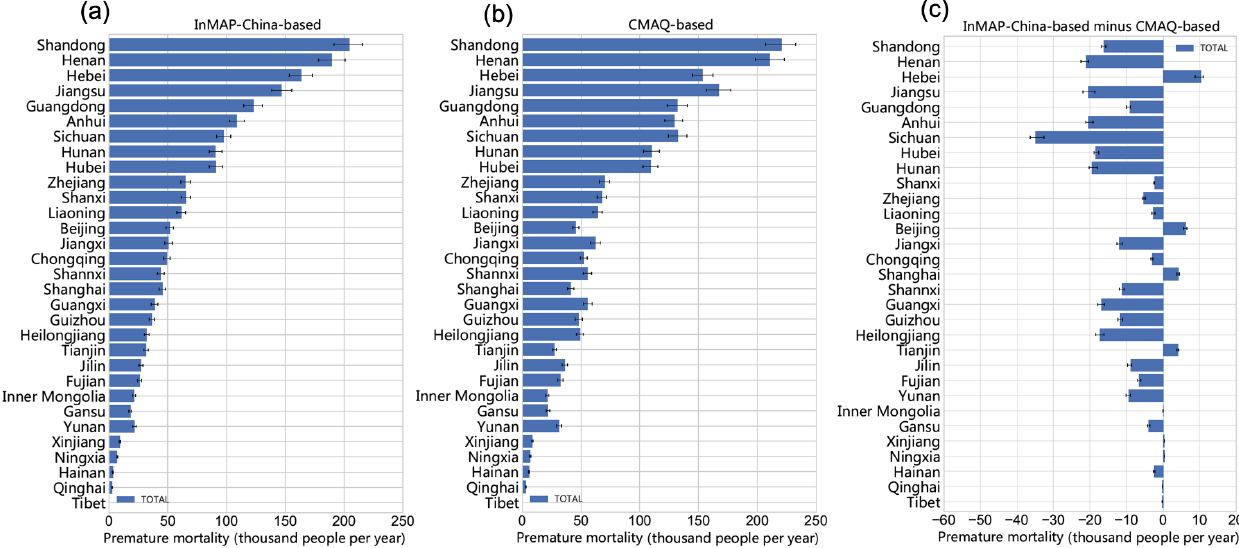
Figure 13. Comparison of PM 2 . 5 -related premature mortality using the PM 2 . 5 predictions from the two models. The panels show (a) InMAP- China-based values, (b) CMAQ-based values and (c) the difference between the two models. Note that we use Shanxi and Shannxi to avoid the duplication of province names. Shanxi is adjacent to Hebei Province, whereas Shannxi is adjacent to Gansu Province.